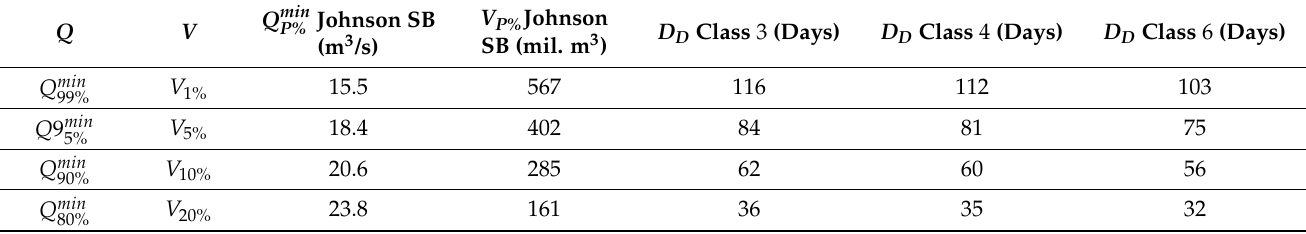
Table 4. SDHs parameters for Johnson SB and Pearson 6 distributions.